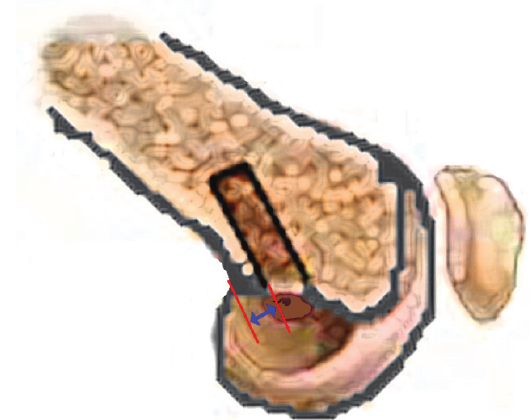
Figure 4 – Inclination of the tunnel in relation to the femoral diaphysis.